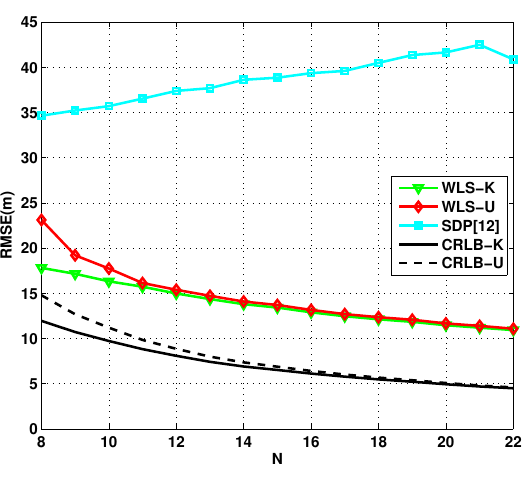
Figure 5. RMSE versus the anchor node number N when σ = 4 dB, α f = 0.01 dB/m ( f = 34 kHz), and ρ = 0.8.